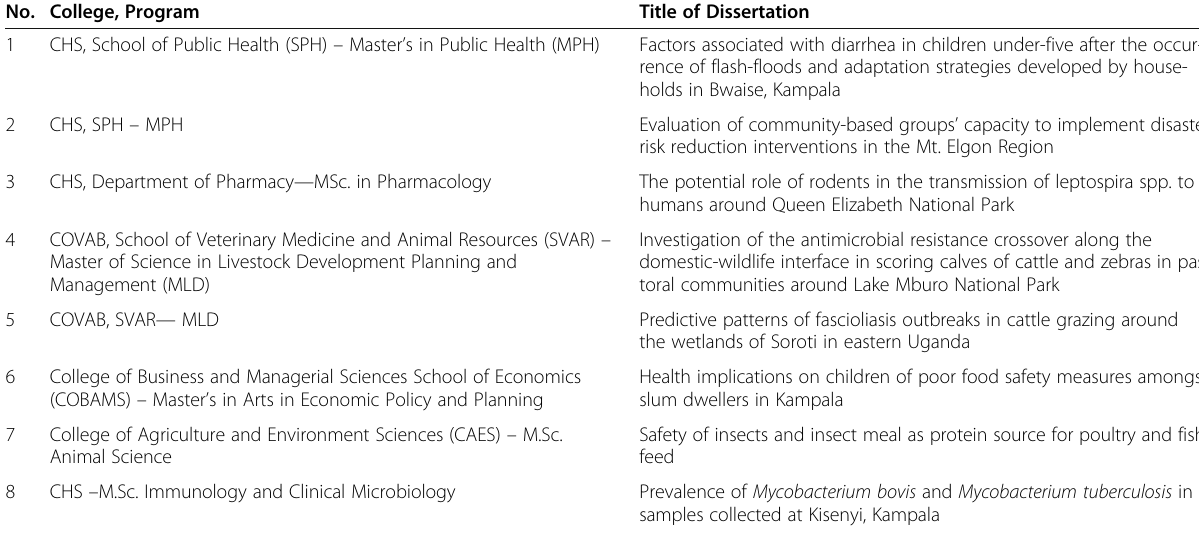
Table 3 Examples of student dissertations supported by One Health research awards No. College,